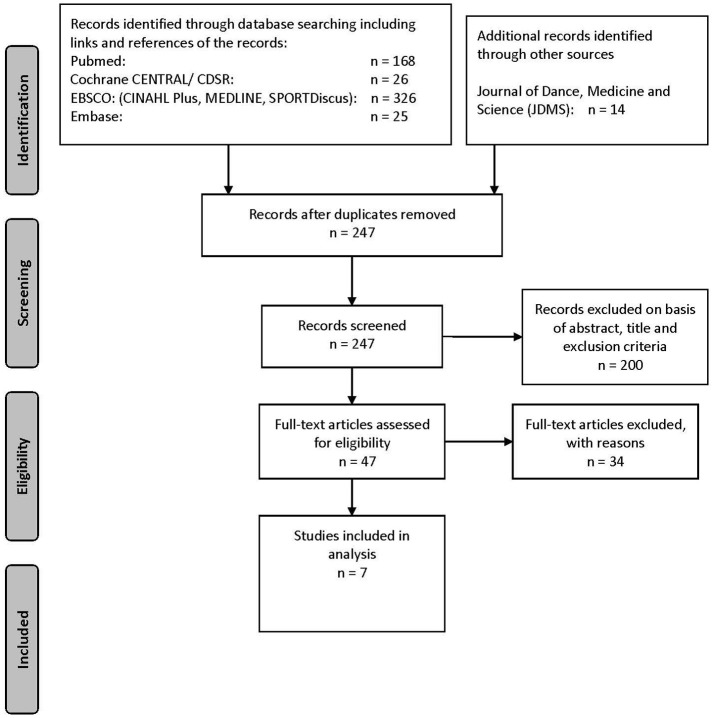
Prisma flow diagram.